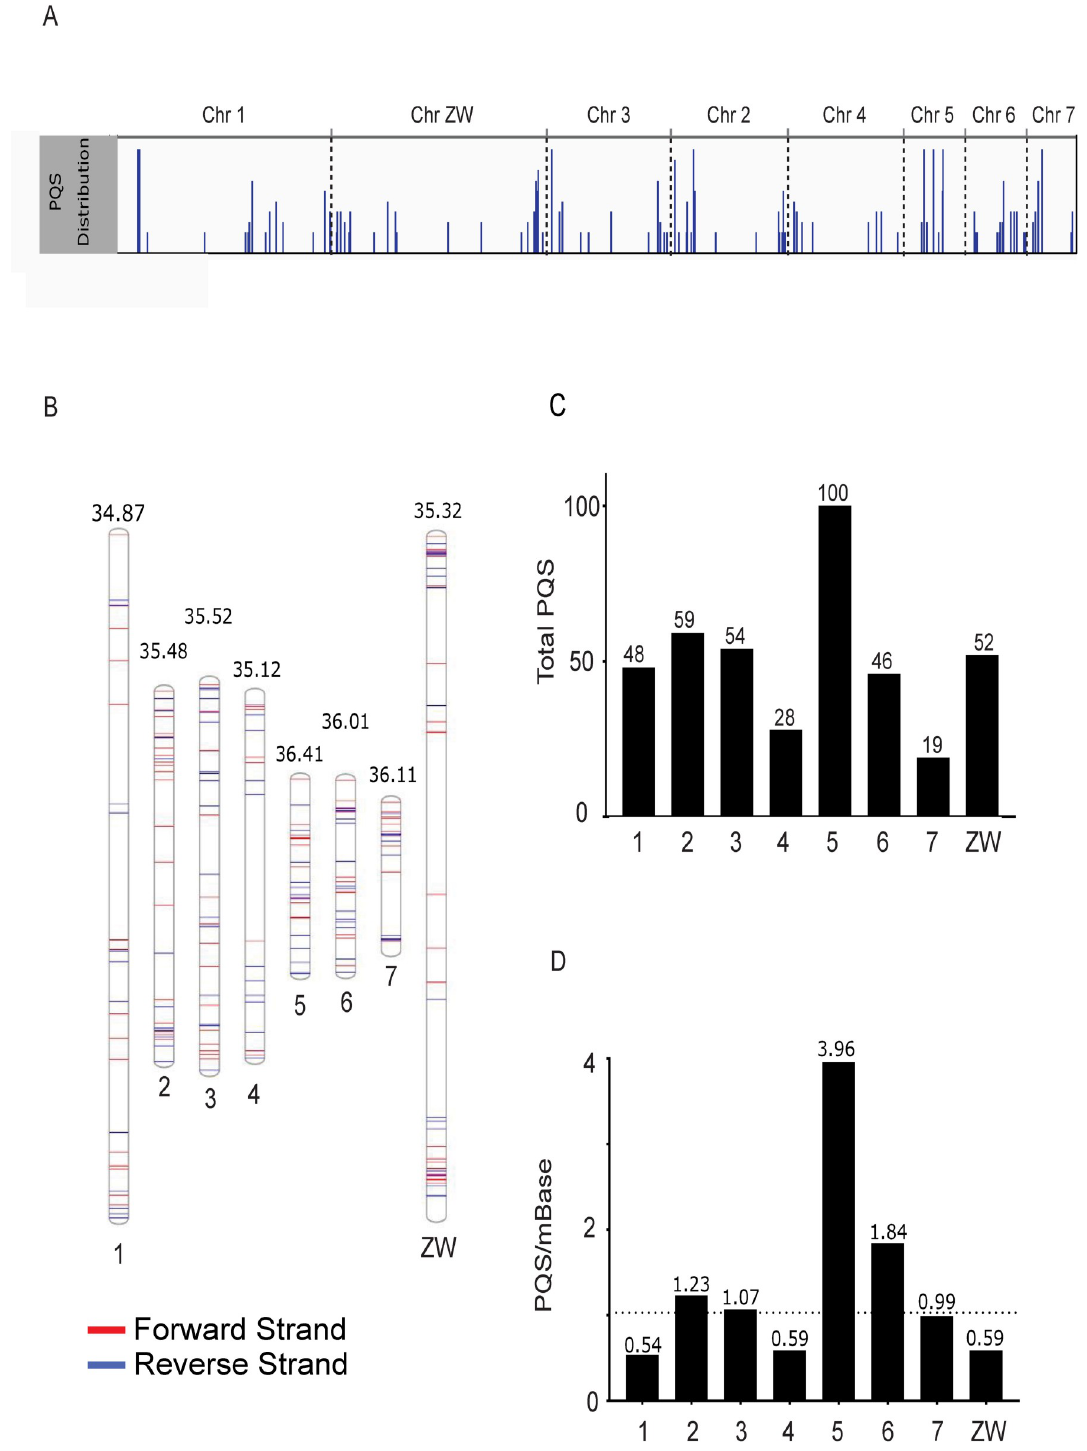
Fig 2. The distribution of PQS across the S . mansoni chromosomal assembly. Both intragenic and intergenic PQS ( n = 406) were mapped to chromosomes ( S . mansoni genome, v7.1). A) IGV snapshot of the chromosomal assembly, where PQS appearing in close proximity are visualised as longer bars. Chromosomes are ordered according to size (largest to smallest). B) A phenogram mapping the position of PQS along the length of the chromosome (autosomes ordered sequentially). PQS appear on both forward and reverse strands. Numbers above each chromosome represent % GC content. C) Total number of PQS identified per chromosome (sequentially